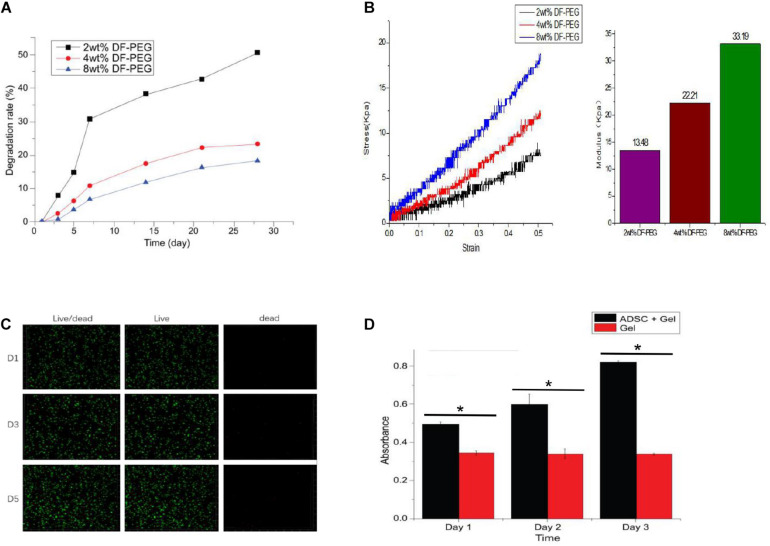
Degradation of hydrogels with different PEG cross-linking concentrations (A), Mechanical testing of different PEG cross-linked hydrogels (B), Inactivated staining of ADSCs in 4% PEG hydrogel (C), and Proliferation assay of ADSCs in 4% PEG hydrogel (D). *P < 0.05.